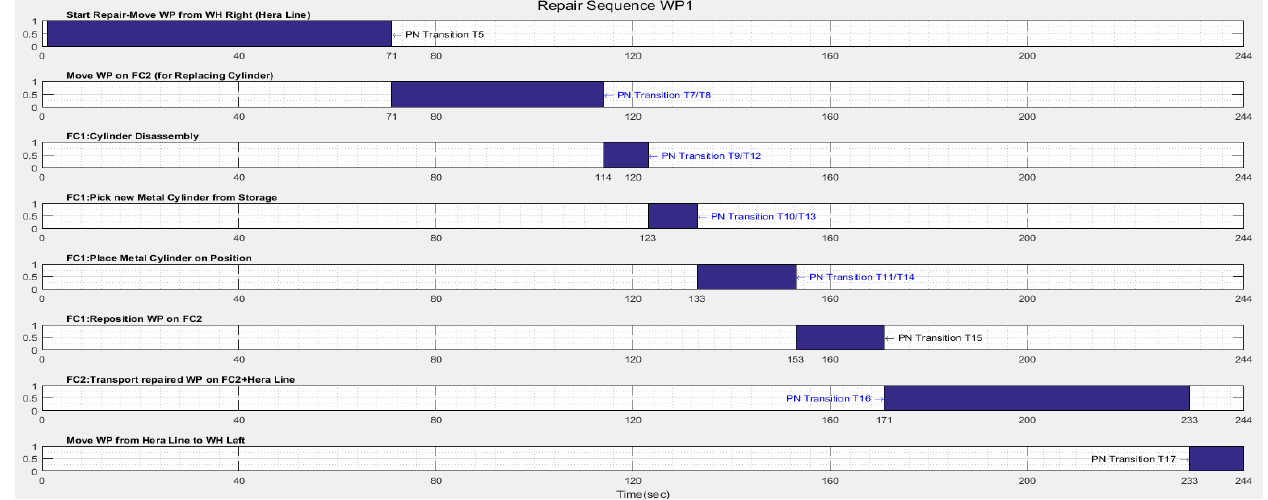
Figure 28. Results for continuous and discrete places associated with displacements of ARS and FC with IRM for Repair.